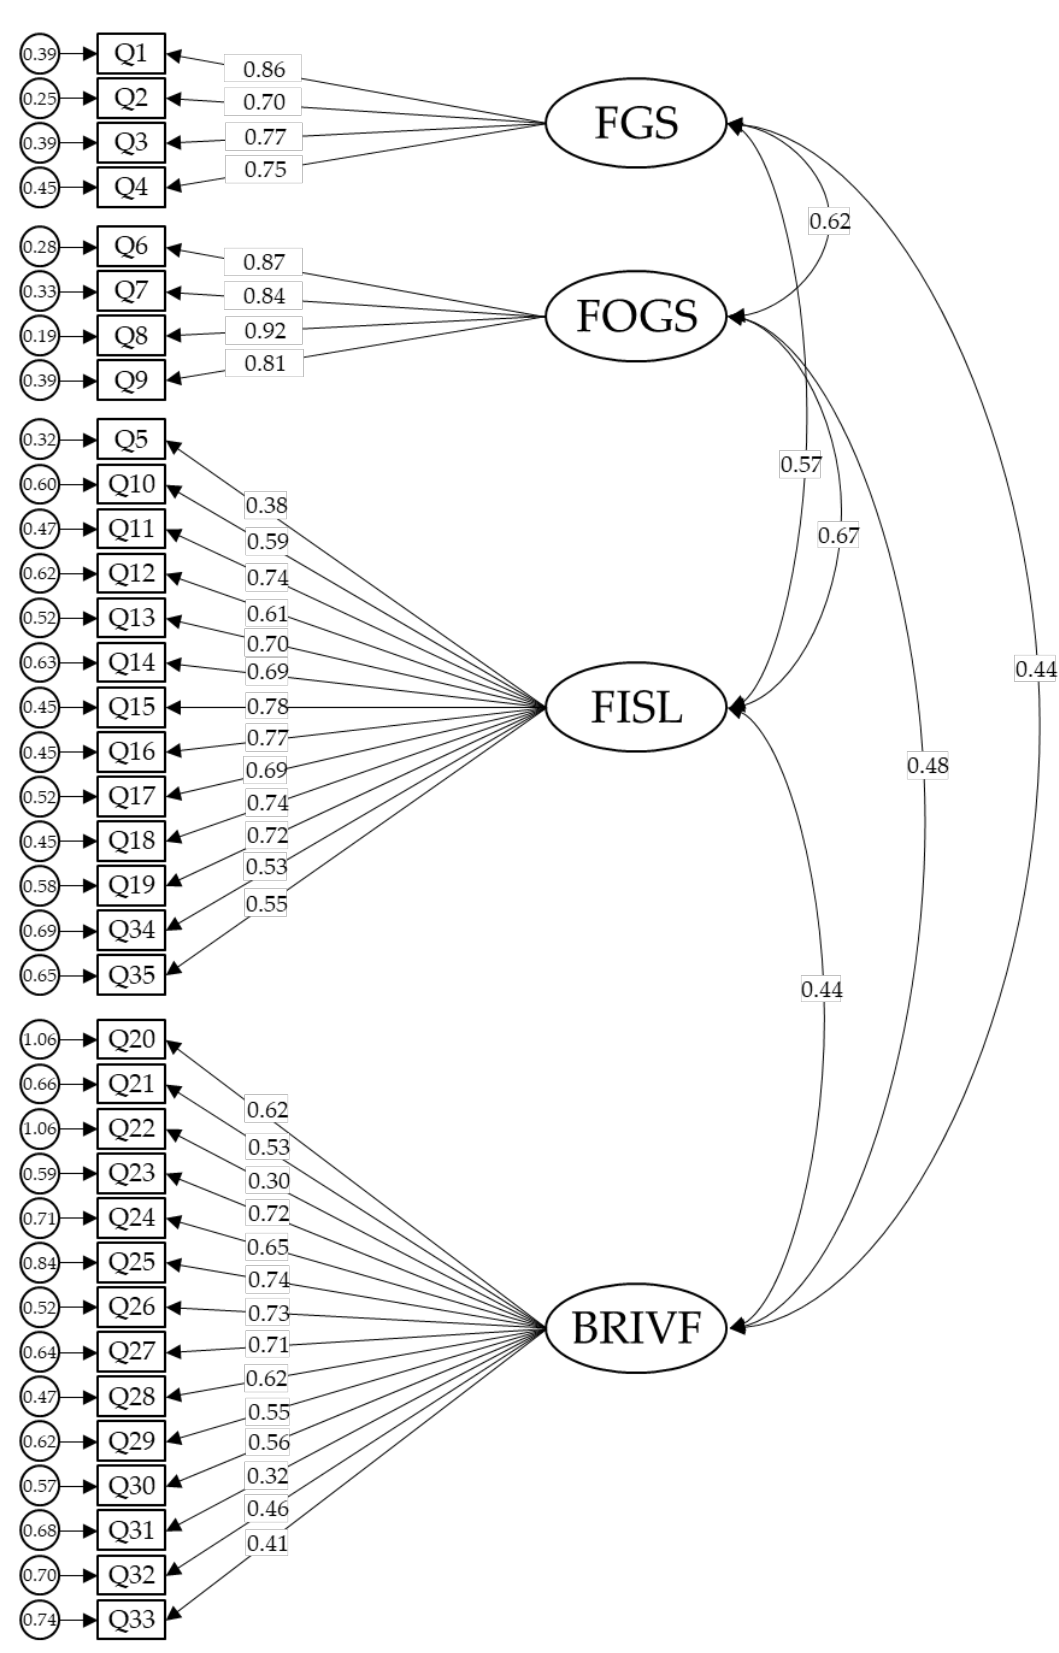
Figure 1. CFA for FIVE proposed four factors. Note: the ellipses represent the factors and the rectangles represent the different items. The residual variances are shown in the small circles. Fears of Getting Sick (FGS), Fears that Others Get Sick (FOGS), Fears of the Impact on Social Life (FISL), Behaviors Related to Illness and Virus Fears (BRIVF).